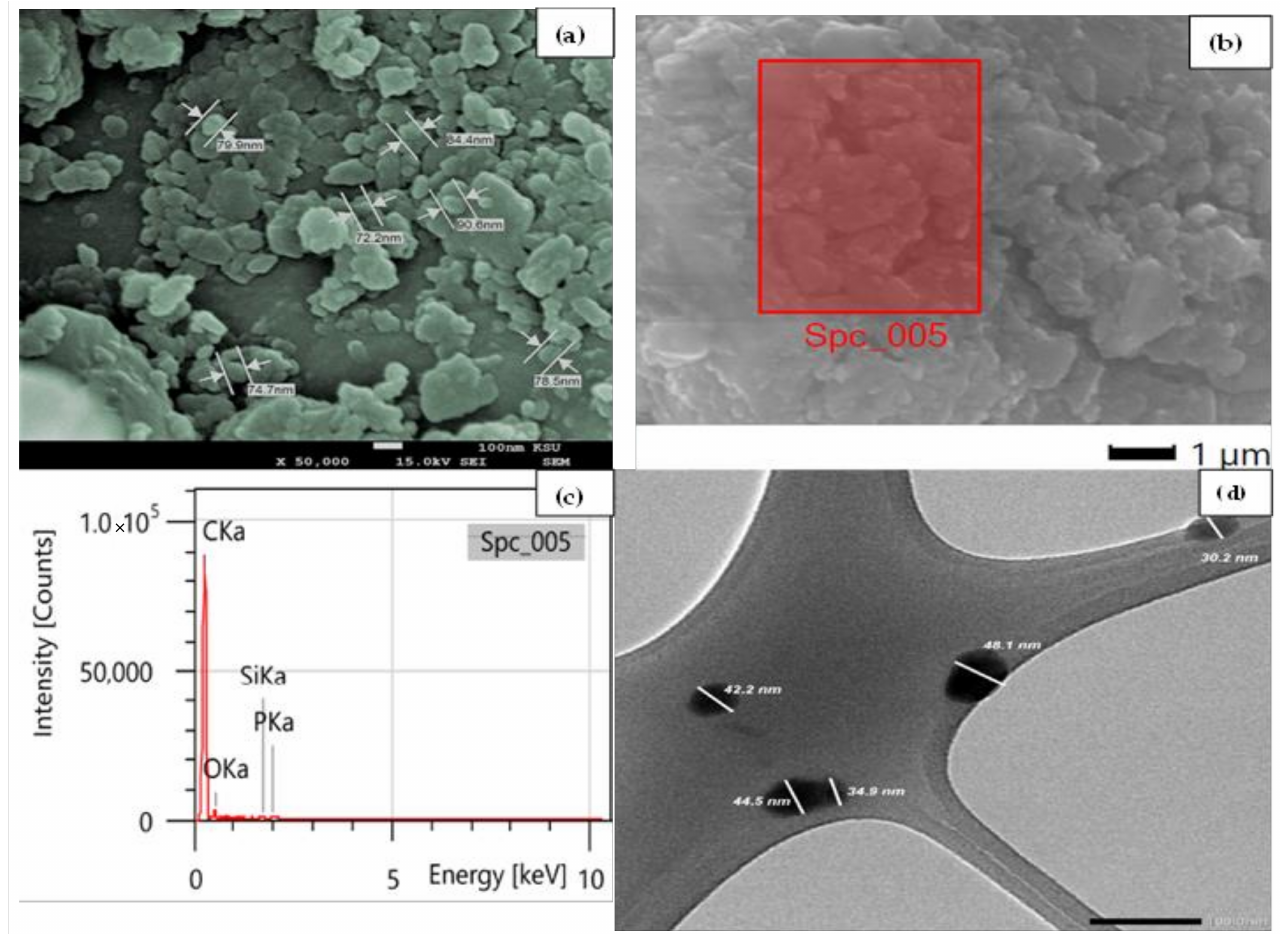
Figure 1. ( a ) SEM images, ( b ) electronic image from the EDX analysis, ( c ) EDX elemental results, and ( d ) TEM results for the prepared CRNPs.